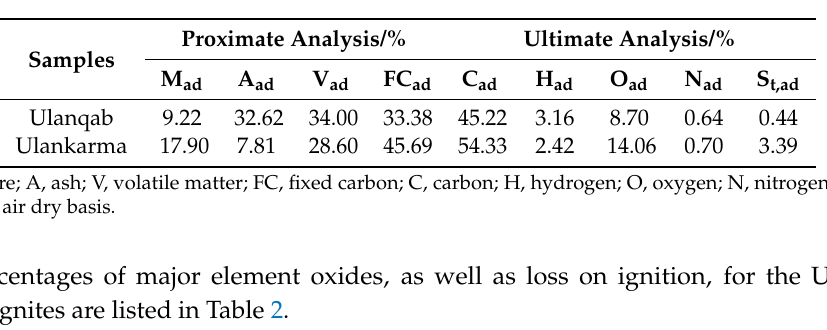
Table 1. Proximate and ultimate analysis of coals